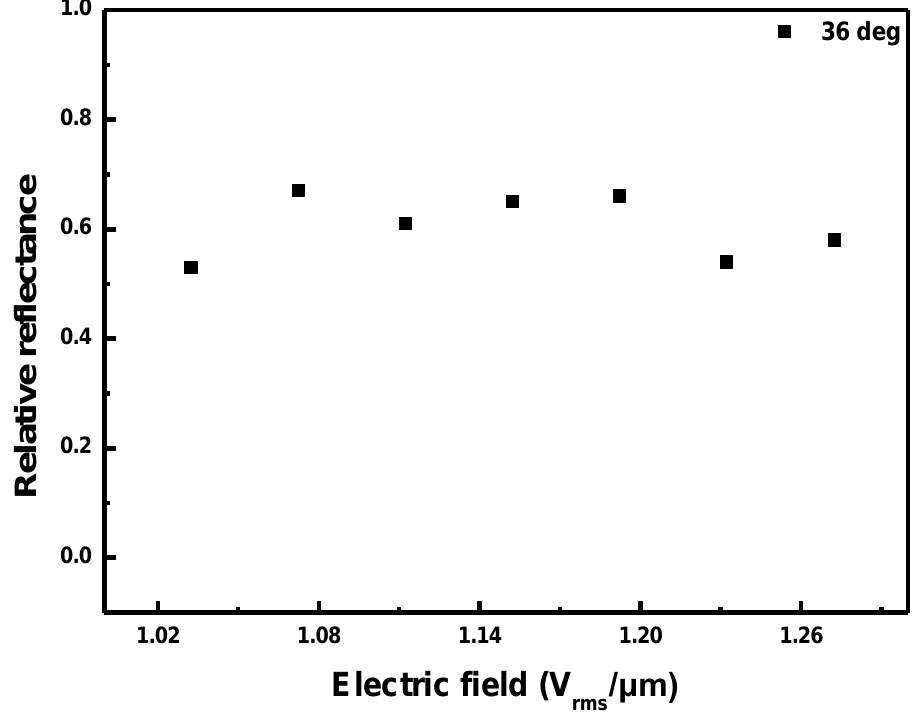
Figure 9. Relative reflectance of the CLC cell according to the applied electric field when the angle of incidence to the CLC cell was fixed to 36 ◦ .